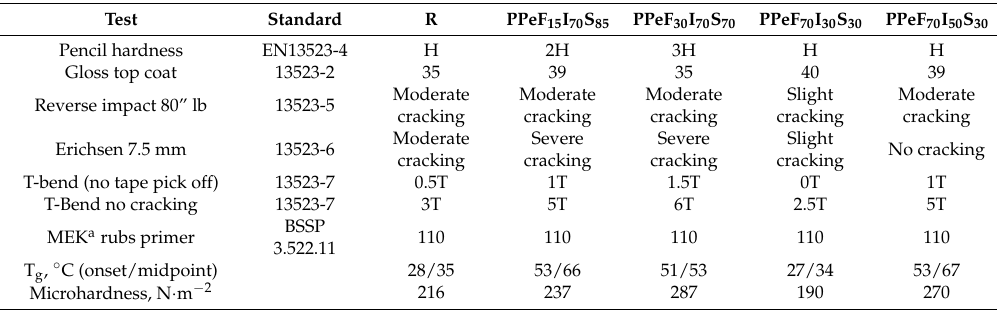
Table 5. Physical test results on white paints based on polyesters PPeF 15 IS 85 -PPeF 70 IS 30 and the standard reference resin R.